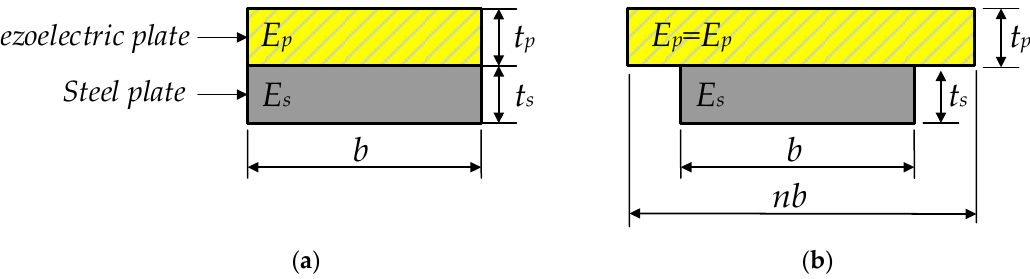
Figure 4. Cross sectional area transformation in composite unimorph section: ( a ) In original, cross sectional area is the same; ( b ) width of piezoelectric plate is varied to be equaled to the same material depend on the modular ratio of different Young’s modulus .